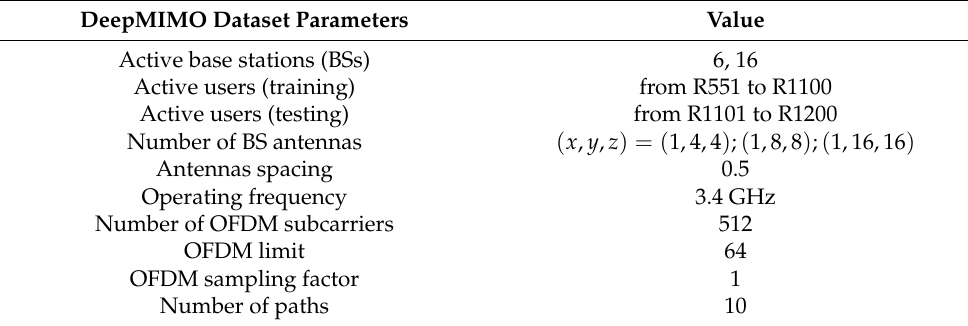
Table 3. The adopted DeepMIMO dataset parameters.